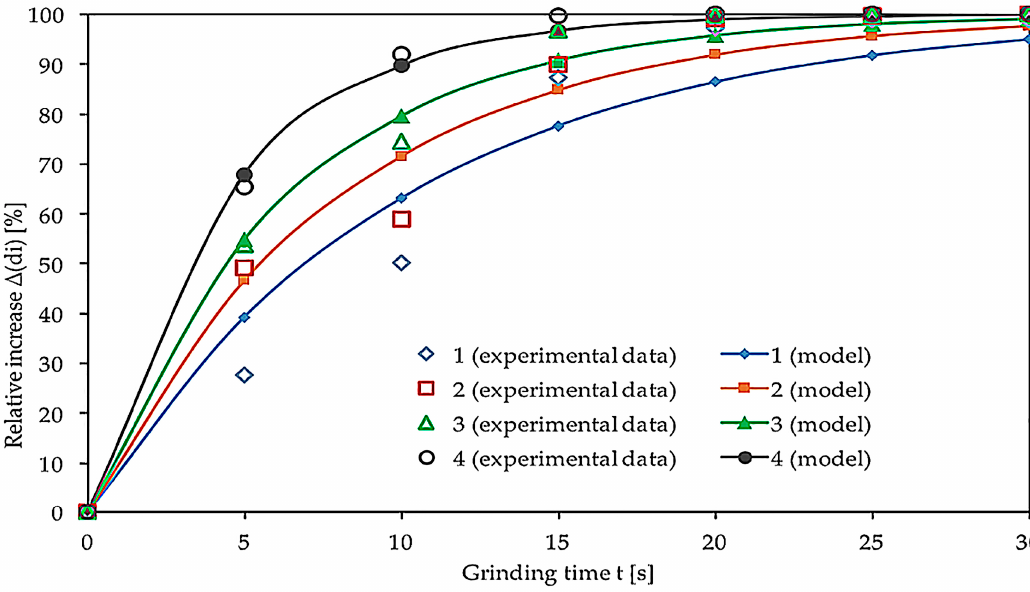
Figure 5. Curves of the relative increment of the 0–0.071 mm particle size fraction in the comminution product for the investigated grinding media characteristics.